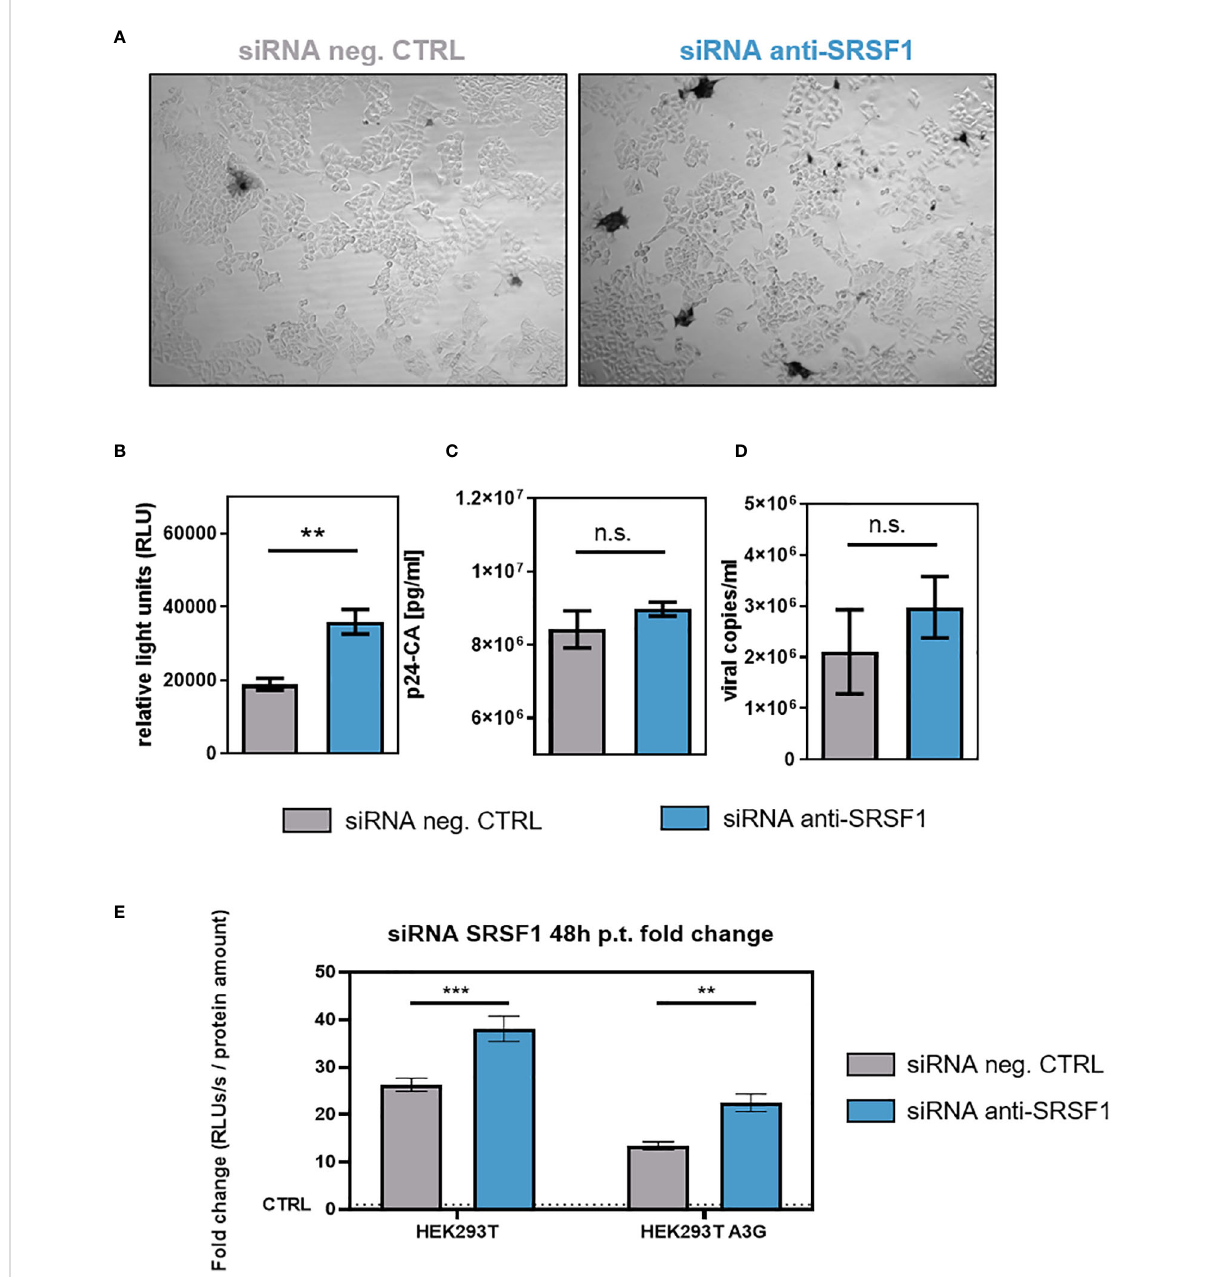
FIGURE 8 Impact of siRNA-based knockdown of SRSF1 on HIV-1 infectivity and virus production. RPE-ISRE luc cells were transfected with a plasmid coding for the proviral clone NL4-3 (AD8) (pNL4-3 AD8) and the indicated siRNA. Seventy-two hours post-transfection, cellular supernatant was harvested. (A, B) Viral infectivity was determined via TZM-bl assay. (A) Infected TZM-bl cells were stained with X-Gal. (B) Luciferase activity was determined measuring relative light units (RLUs). (C) p24-CA ELISA was performed to determine p24-CA levels in the cellular supernatant. (D) Cellular supernatant was used to determine viral copy number per milliliter. RT-qPCR was performed analyzing absolute expression levels of exon 7-containing transcripts (total viral mRNA). Statistical signi fi cance was determined using unpaired two-tailed t -tests (** p < 0.01). Mean ( ± SEM) of n = 4 biological replicates is shown for (B) , (C) , and (D) . (E) HEK293T- and HEK293T APOBEC3G-expressing cells were seeded in poly- L-lysine (Sigma-Aldrich) pre-coated wells. Cells were transiently transfected with the proviral clone pNL4-3 and 12.8 nM of the indicated siRNA. Supernatants were harvested 48 h post-transfection and applied to TZM-bl cells. Forty-eight hours post-infection, cells were lysed for luciferase assay. The RLUs/s were normalized to whole protein amounts as determined using Bradford assay. The fold change is normalized to the signal of uninfected TZM-bl cells. Mean ( ± SEM) of n = 4 biological replicates and n = 2 technical replicates is shown. The signi fi cance was analyzed using two-way ANOVA (** p < 0.01, *** p < 0.001, and ns, not signi fi